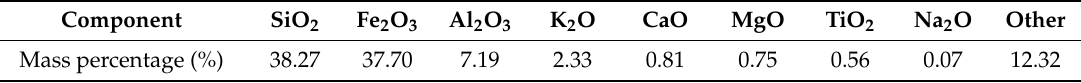
Table 2. Chemical composition of the used tailings (as supplied by the distributor).